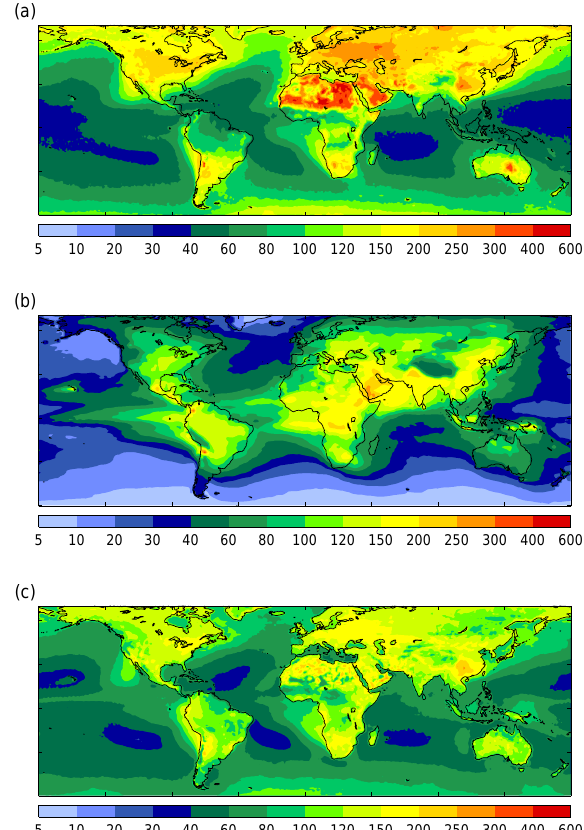
Fig. 2. (a) Annual-mean cloud-top CDNC (cm − 3 ) from MODIS for 2000–2005. (b) As (a) but from ∼ 500–1500m altitude in HadGEM2-ES. (c) As (a) but from CERES/MODIS for